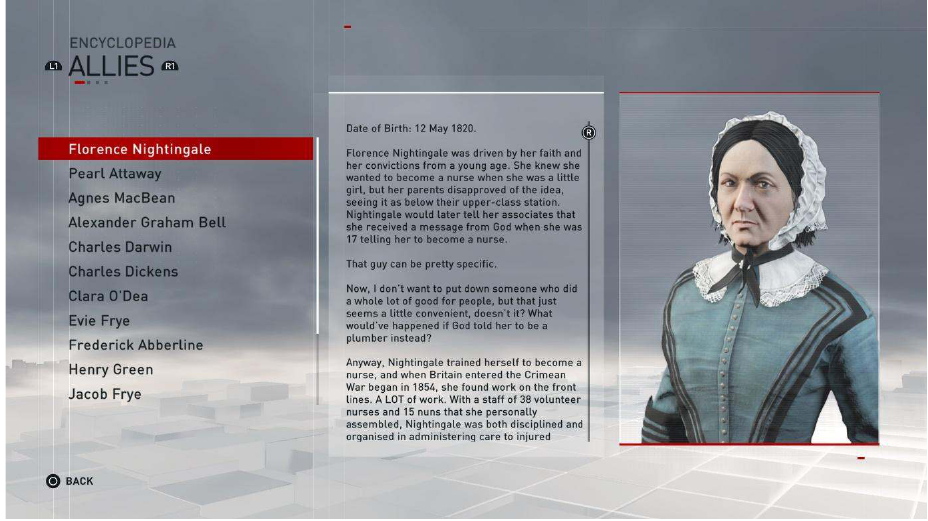
Credits: Assassin’s Creed Syndicate ,